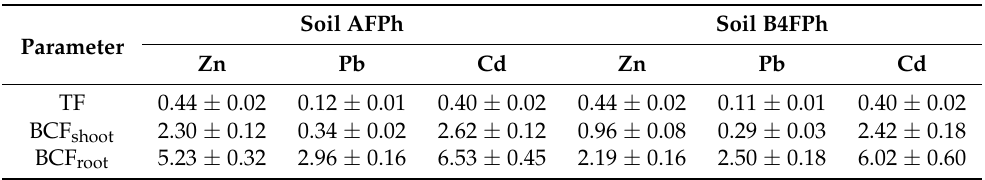
Figure 7. Concentration of Zn, Pb and Cd in the biomass (shoots and roots) after 6-month phytore- mediation enhanced by fertilization of soils AFPh and B4FPh (repetition number n = 3, p < 0.05). Table 2. Parameters describing the capacity, efficiency and usefulness of M. officinalis after 6 months of phytoremediation (Zn, Pb, Cd) augmented by soils fertilisation AFPh and B4FPh (repetitions number n = 3, p <